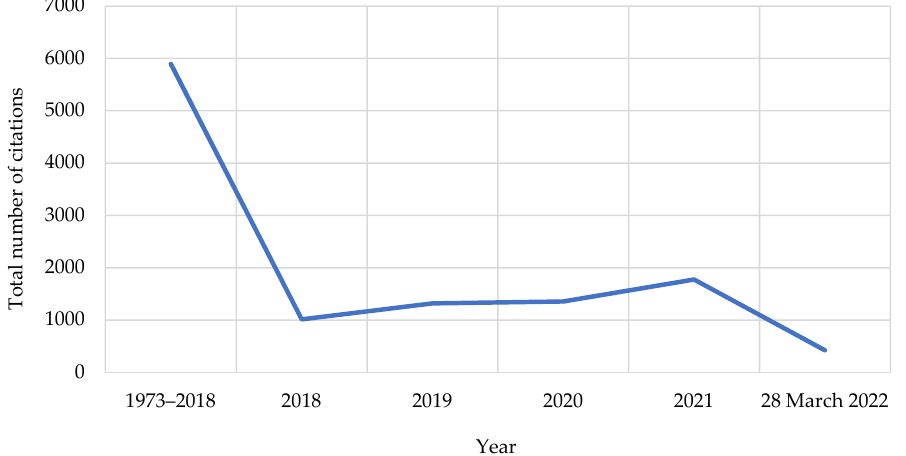
Figure 2. Publication trend of original research articles on milk fluoridation.